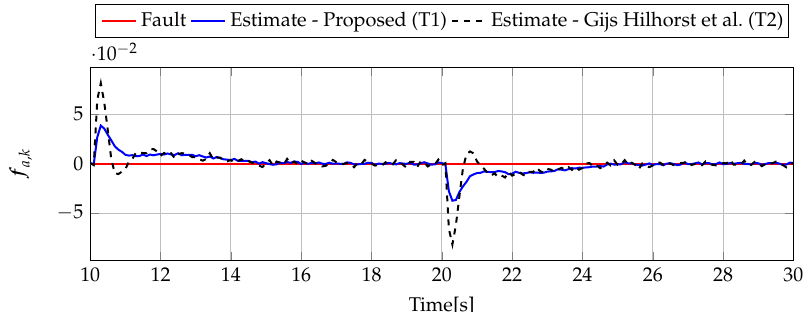
Figure 3. Actuator fault estimate for the fault–free case (for t = 10, . . . ,30) with Theorem 1 (T1) and Theorem 2 (T2), based on [39] for disturbance signal w 1, k .